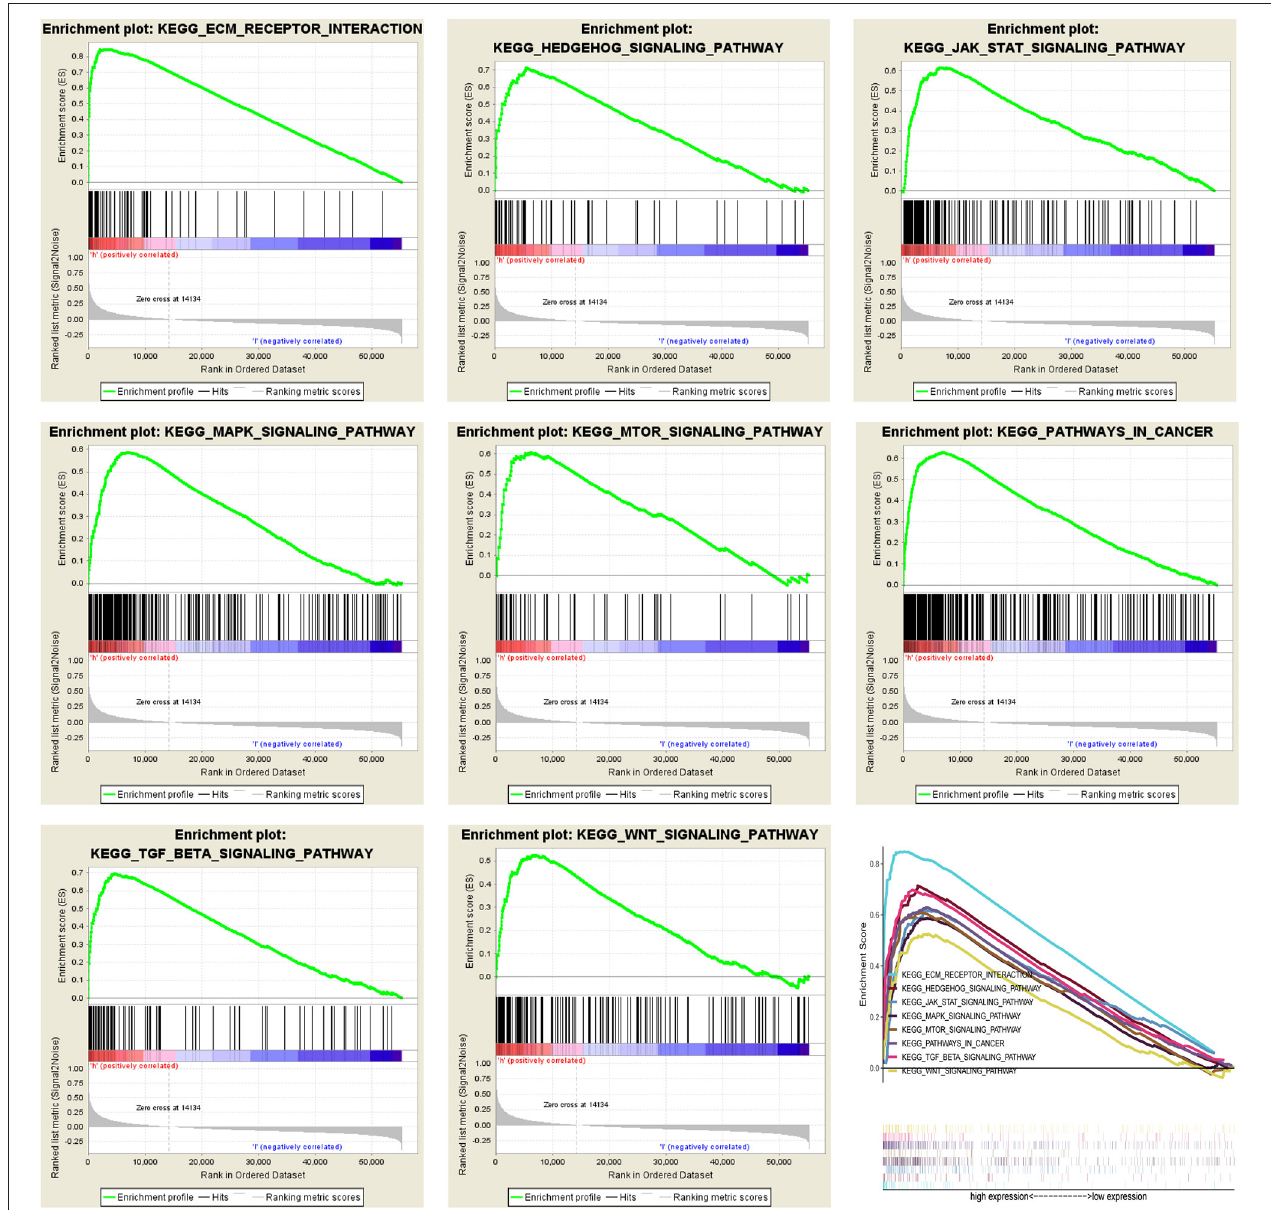
FIGURE 6 | Merged enrichment maps from gene set enrichment analysis (GSEA), including enrichment scores and gene sets. Significantly enriched signaling pathways include ECM-receptor-interaction, pathways in cancer, Hedgehog signaling, TGF-beta signaling, JAK-STAT signaling, MAPK signaling, Wnt signaling, mTOR